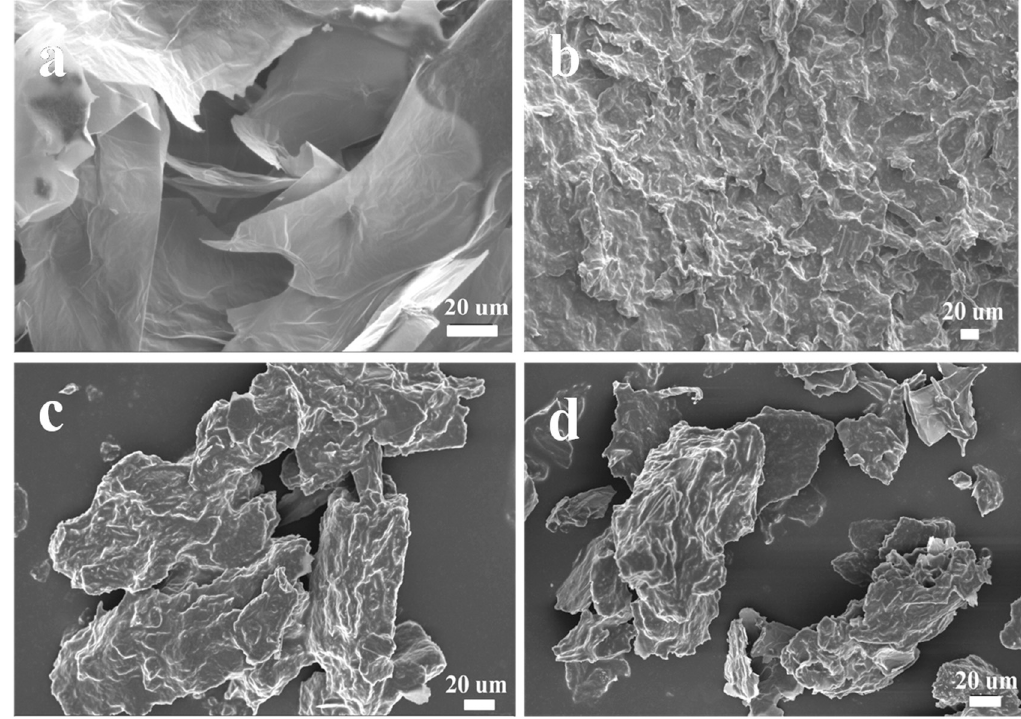
Figure 4. Scanning electron microscopy (SEM) micrographs of ( a ) GO, ( b ) SPCM8, ( c ) SPCM10, and